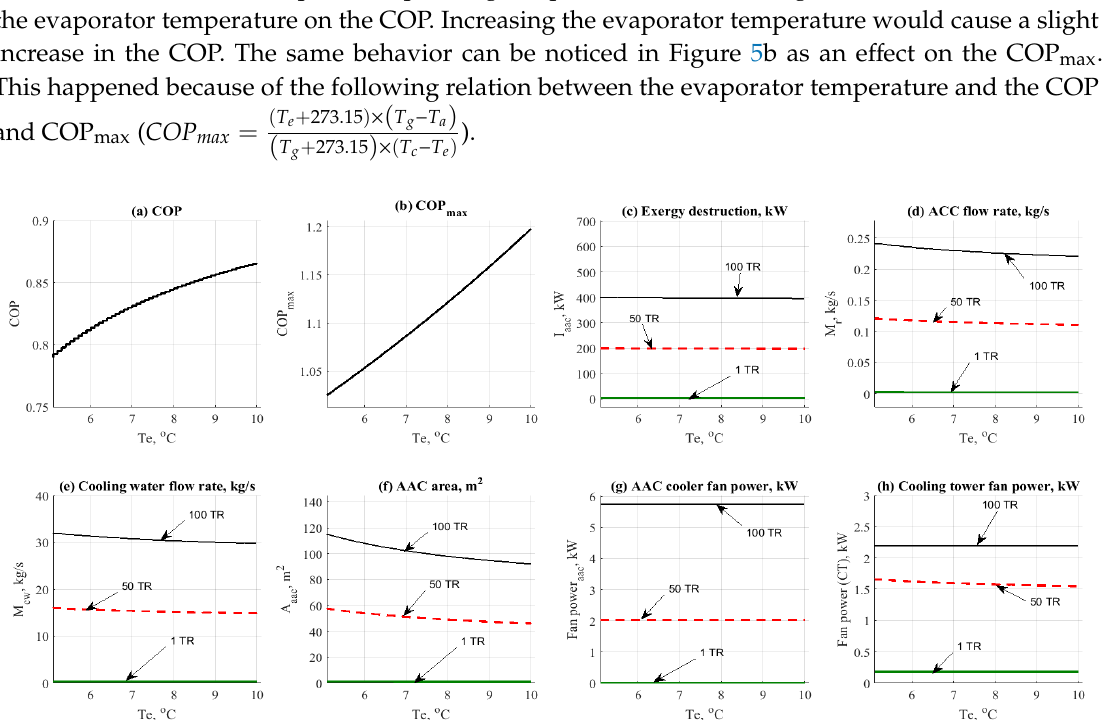
ff ect of evaporator temperature Figure 5. Data results based on the effect of evaporator temperature parameter. Figure 5. Data results based on the e